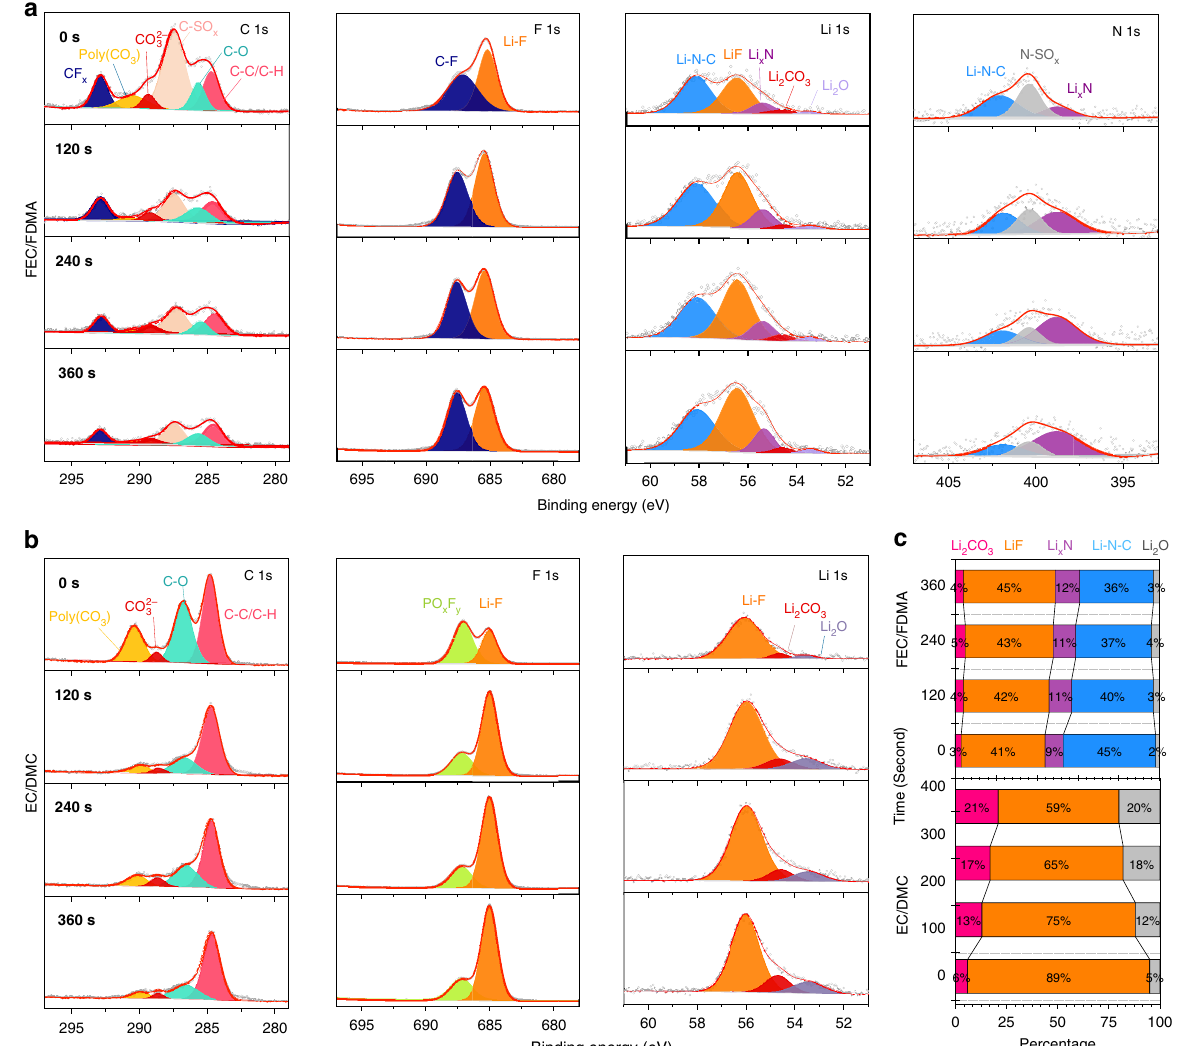
Fig. 4 Components on the surface of anodes after cycling. a , b X-ray photoelectron spectroscopy (XPS) depth pro fi les of C 1s, F 1s, Li 1s and N 1s spectra of Li metal anodes after 50 cycles for both electrolytes. c The relative composition of Li-containing